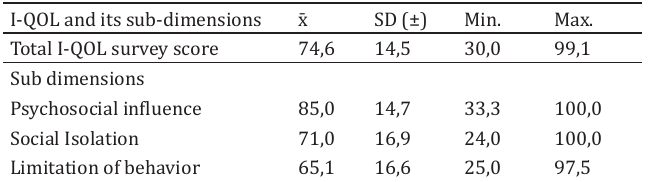
Analysis of women's I-QOL total and sub- dimension mean scores (n=90)